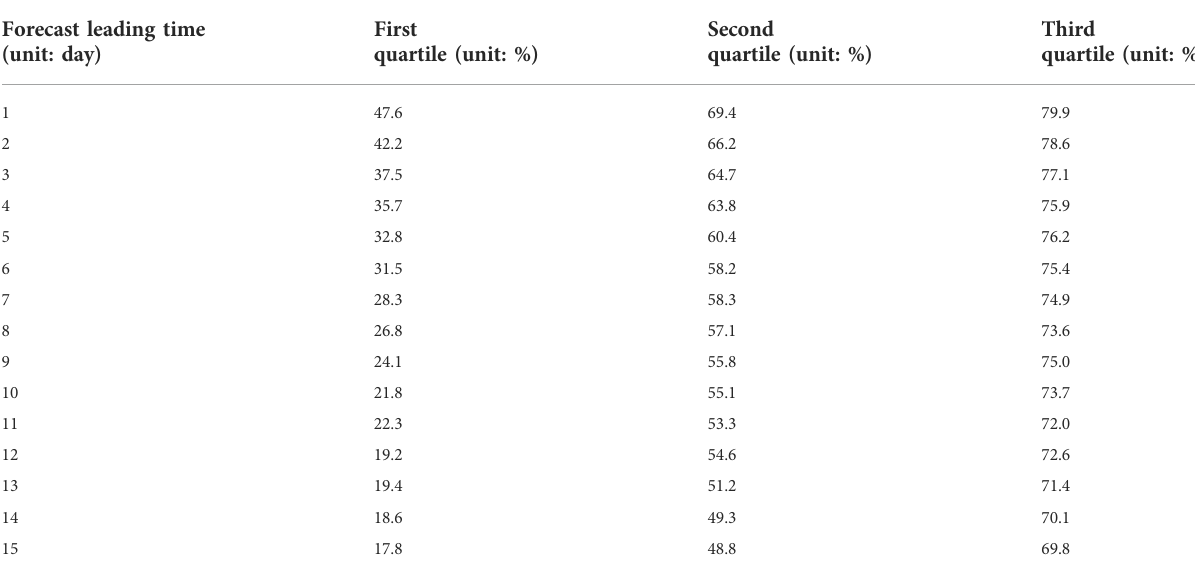
First quartile (unit: %)